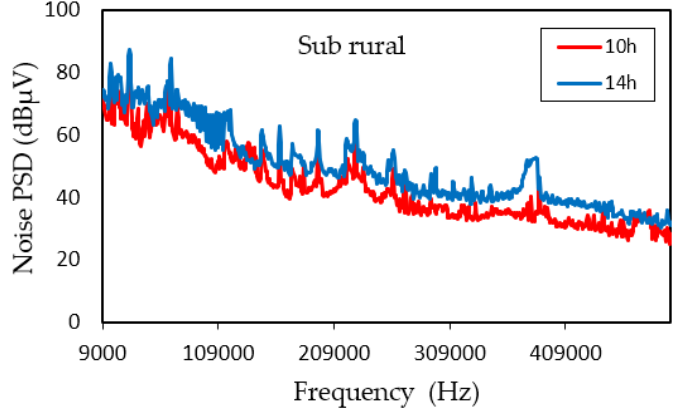
Figure 10. Noise power spectrum in the transformer substation. Measurements performed at 10 a.m. and 2 p.m.